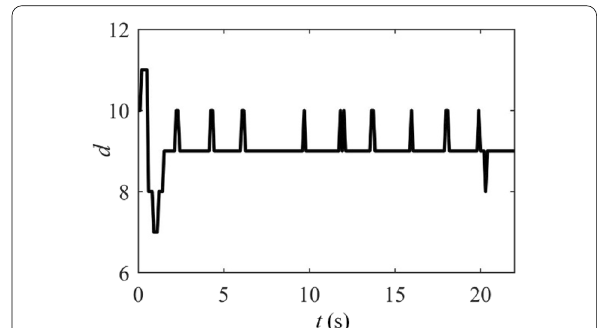
Figure 22 Point of maximum magnetic field signal